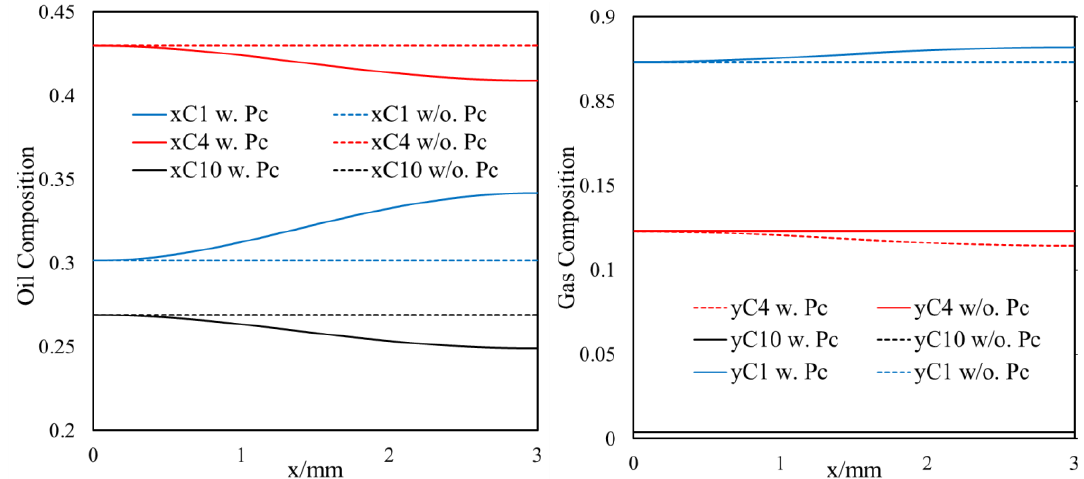
Figure 5. Initial oil and gas phase compositions with and without capillary pressure, ternary mixture. (In the legends, w. refers to with, and w/o. refers to without.).